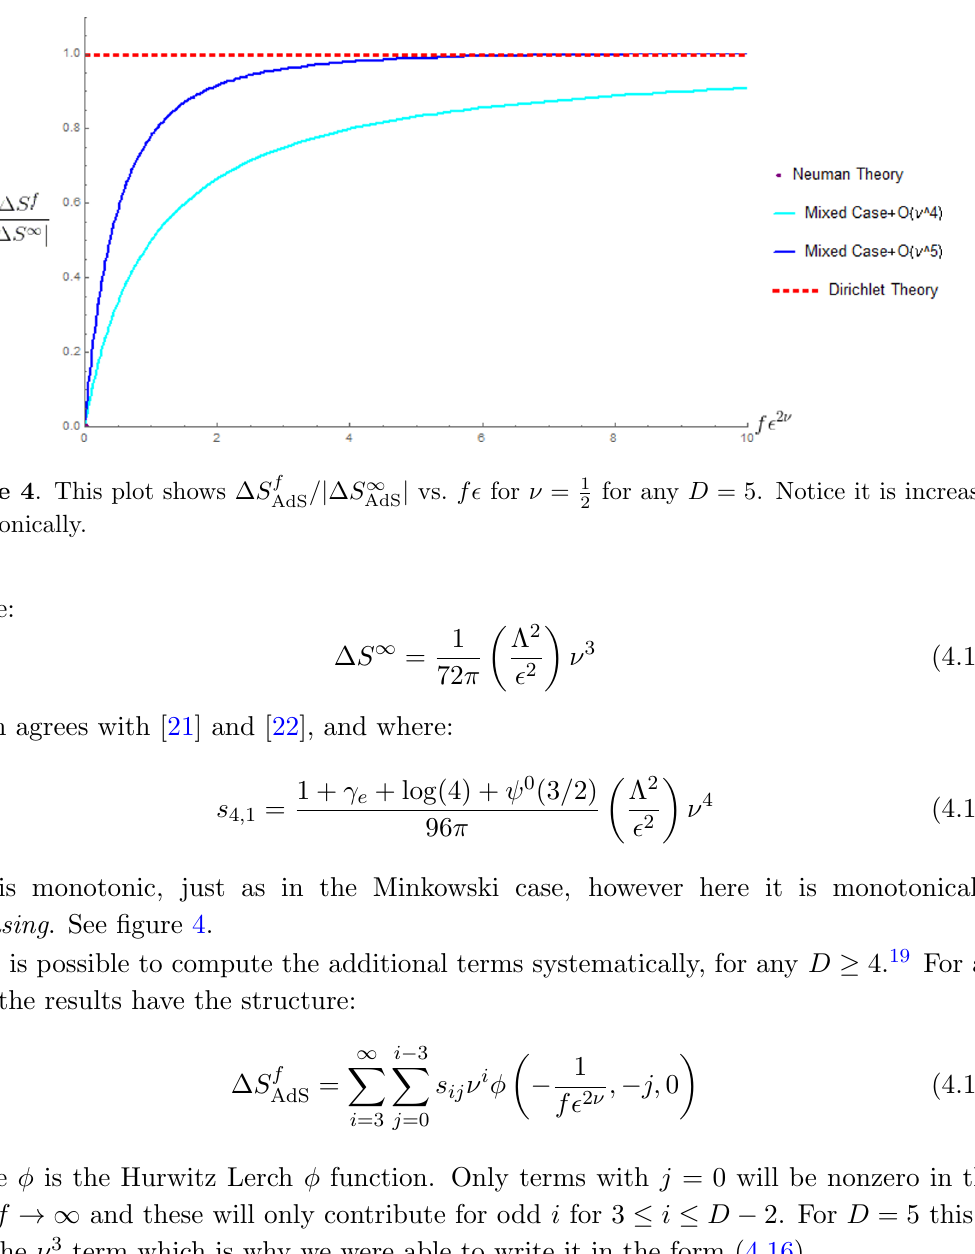
Figure 4 . This plot shows (cid:1) S f